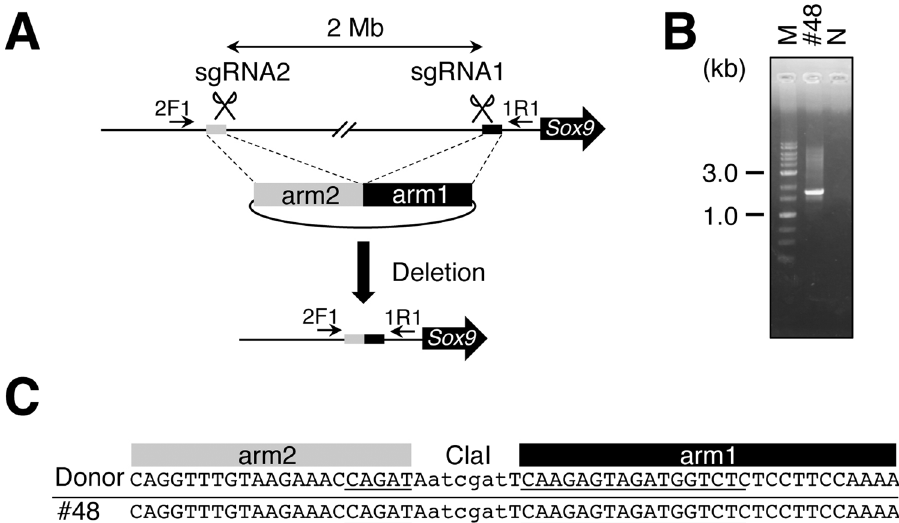
Figure 1. Creation of mutant mice with a 2-Mb deletion with a donor plasmid. ( A ) Schematic representation of the 2-Mb region upstream of Sox9 . The black line represents genome sequence. Homology arms are indicated with black and gray boxes. PCR primers are indicated with arrows. Positions of sgRNA recognition sequences are indicated with scissors. ( B ) An agarose gel electrophoretogram image of PCR products amplified using 2F1 and 1R1 primers and DNA prepared from #48 embryo. M: a 1-kb DNA ladder (molecular weight markers); N: no template control. ( C ) Sequence of the deletion junction. Sequences of the donor plasmid and of #48 embryo are aligned. Positions corresponding to arms and the ClaI recognition sequence are indicated at the top. Parts of gRNA recognition sequences are underlined. Black and gray boxes correspond to those of ( A